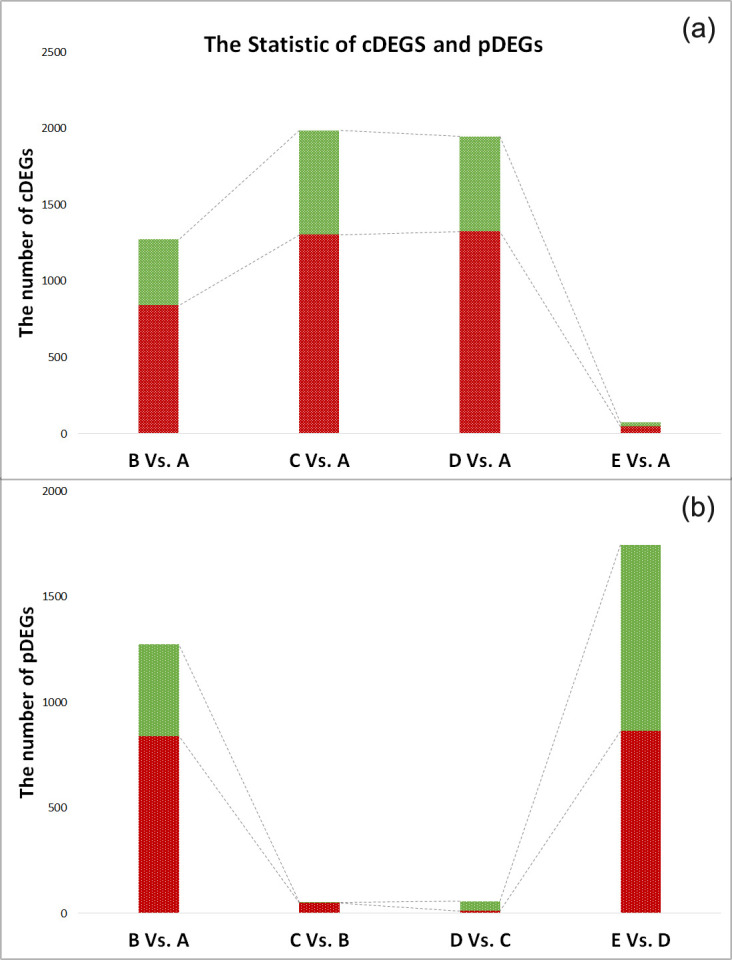
Stacked bar of DEGs.a. The genes differentially expressed (DEGs) in group B (12°C), group C (4°C), group D (12°C) and group E (27°C) in comparison to control group A (27°C). b. The differentially expressed genes between two adjacent groups. In both plots, red represents upregulated genes, and green represents downregulated genes.